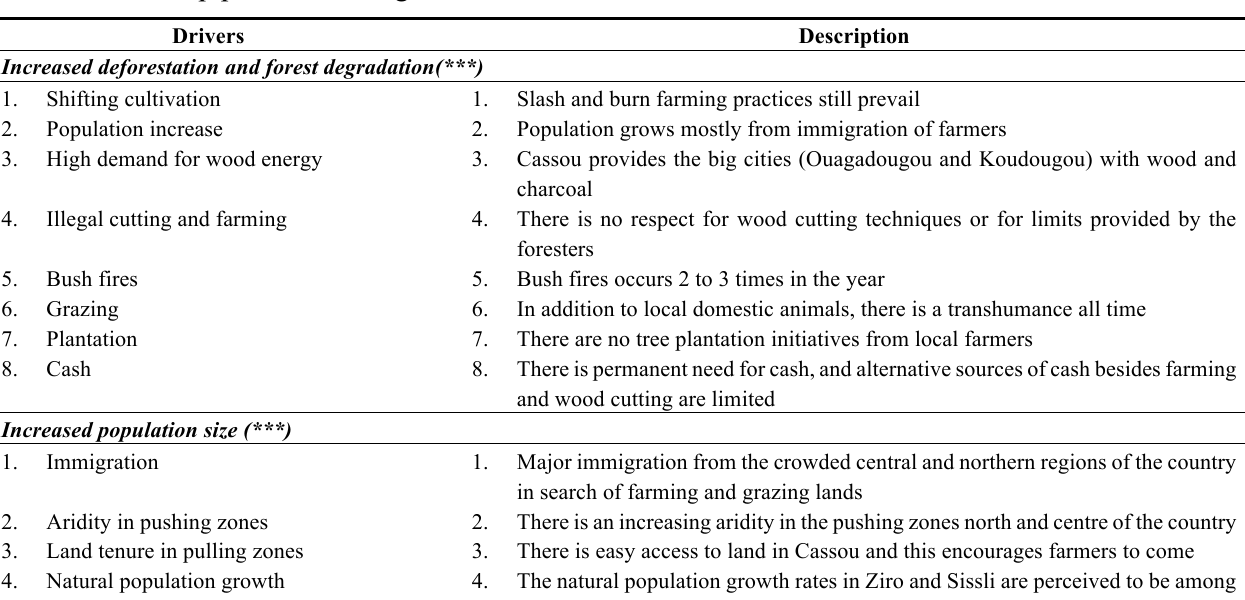
Table 9. Farmers’ perception of drivers of land cover change: deforestation, population, rainfall, crop price and living